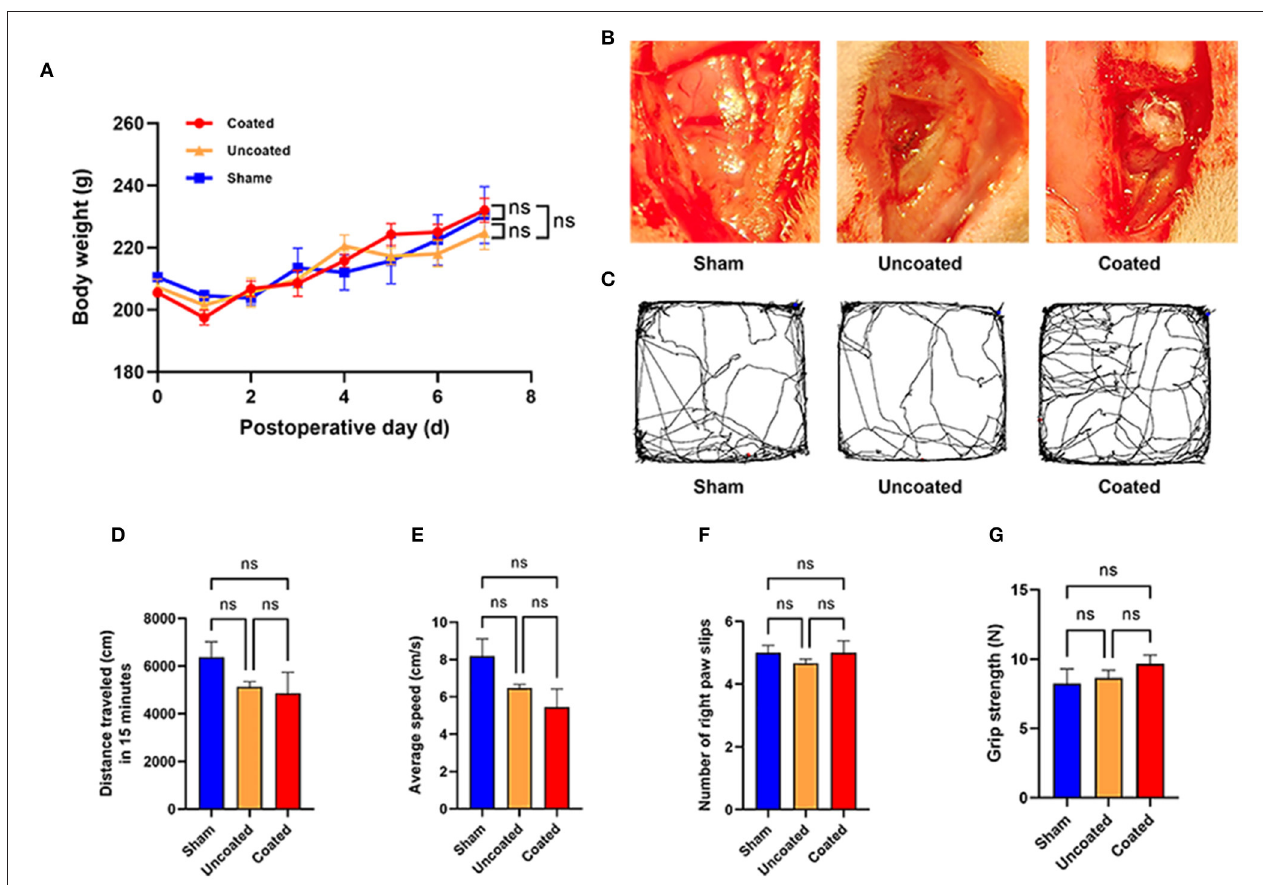
FIGURE 6 | Motor function evaluation of electrocoagulation with BW coated bipolar forceps in rat M1 area. (A) Body weight change during 7 days postoperatively. (B) Operative view of each experimental group. (C) Tracked trajectory of a representative rat in each group during 15min in the open field test. Total distance traveled (D) and average speed (E) in the open field test. (F) Number of the right paw slips in the ladder test. (G) Grip strength of front paws in the grip strength test, n = 4 for each group. ANOVA, ns p >